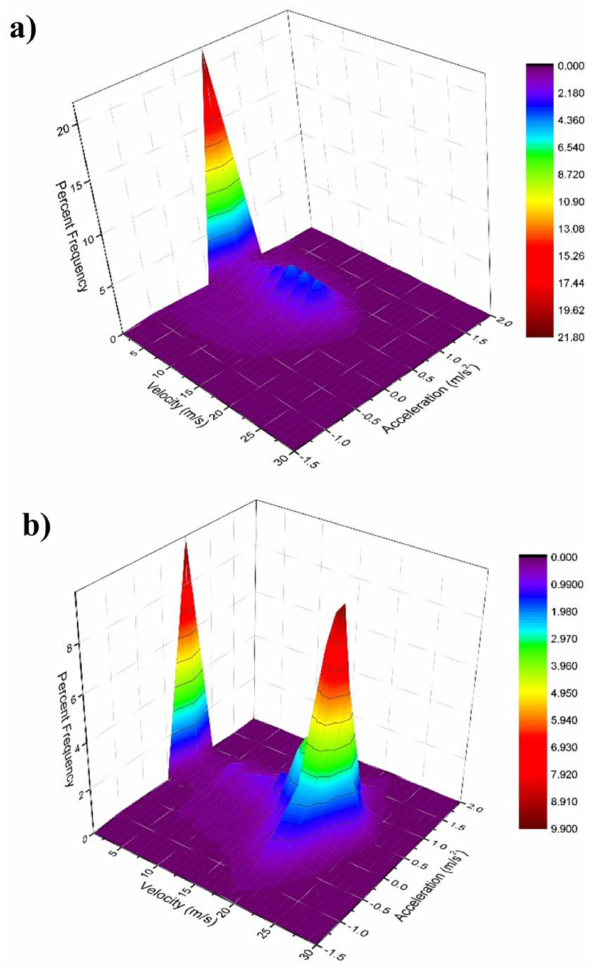
Figure 5. Velocity and acceleration distribution on each type of roads: (a) urban roads and (b) an intercity freeway.